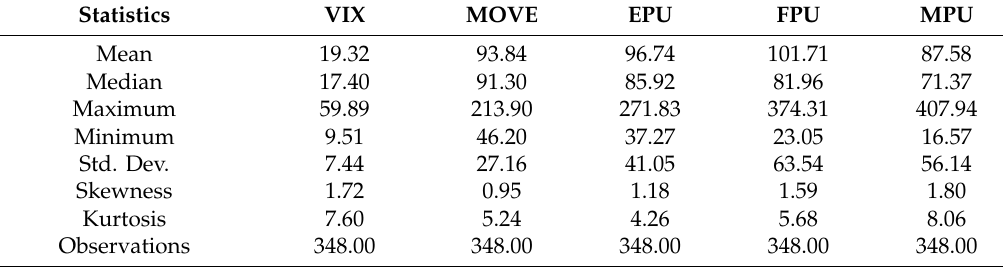
Panel D. Summary of statistics of risk and uncertainty.